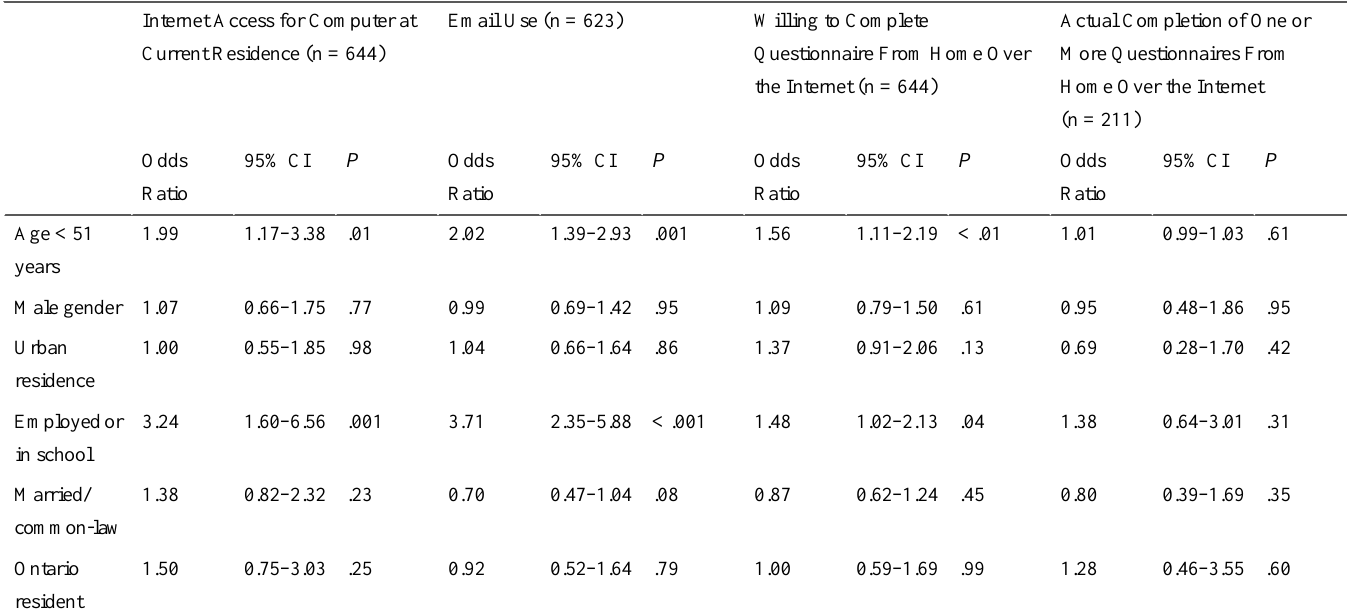
Table 4. Binary logistic regression analysis of factors associated with computer and Internet use